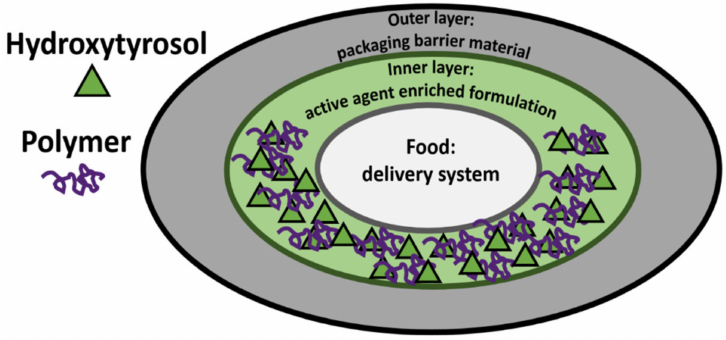
Figure 7. Schematic representation of a possible active packaging systems for hydroxytyrosol